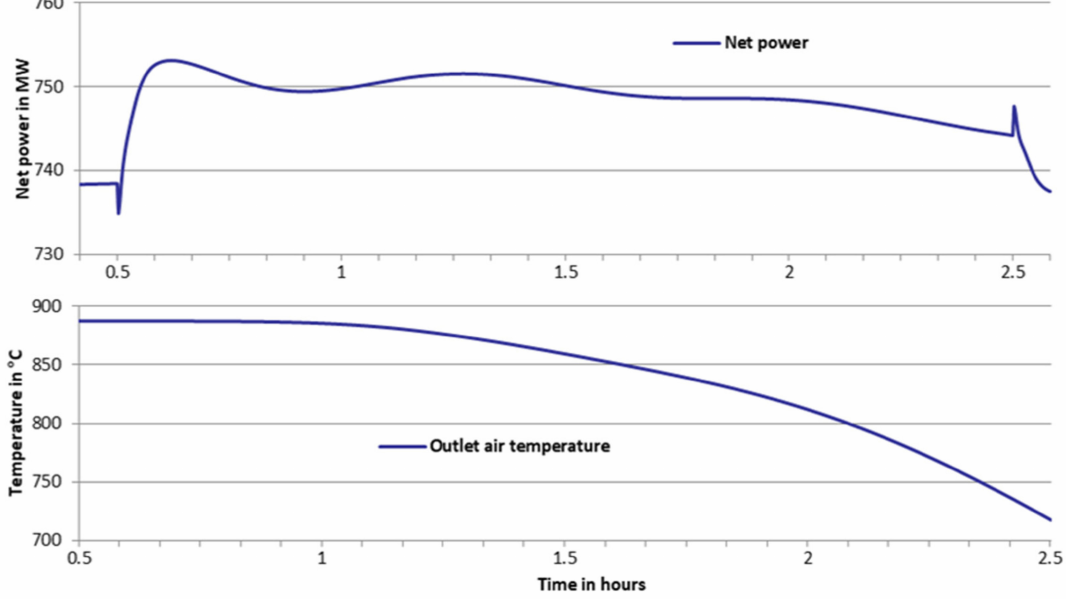
Figure 9. Characteristics of the selected variables during the discharge process (Flue gas- Air_indirectly